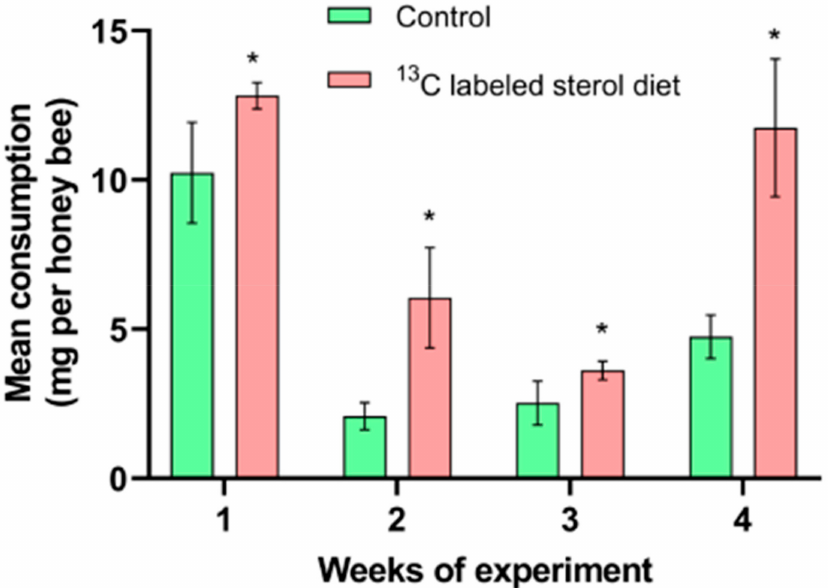
Figure 2. Mean consumption of artificial diets. Control: honey bees fed diet with no sterol; 13